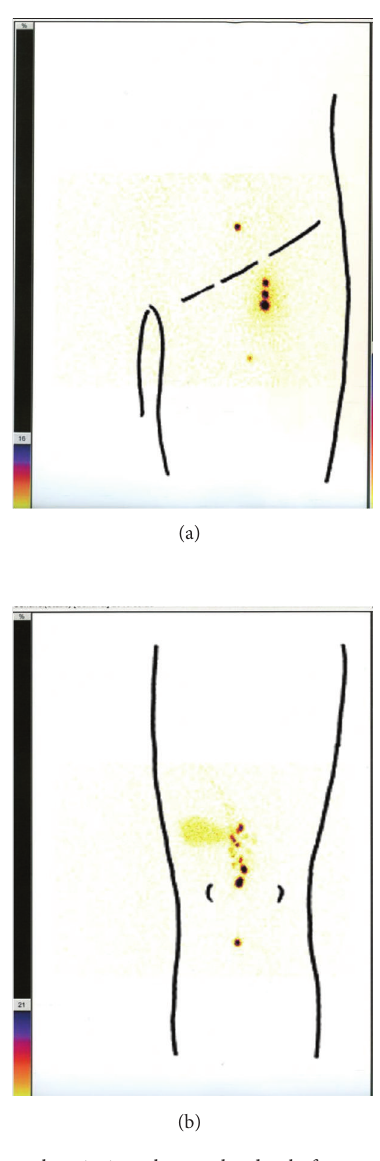
Figure 2: Lymphoscintigraphy on the day before surgery. Lymph nodes were detected in both (a) inguinal and (b) popliteal